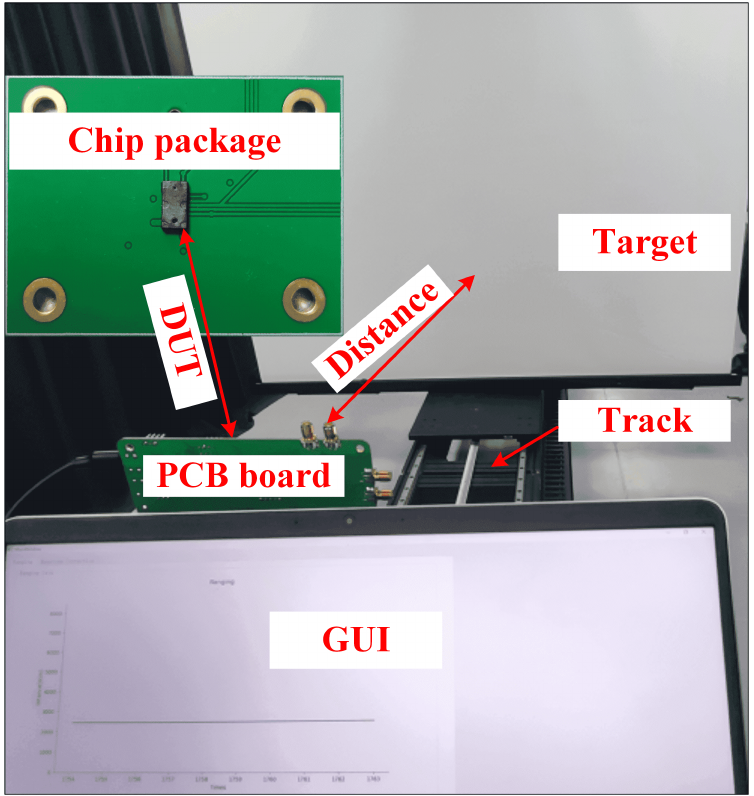
Figure 12. Ranging measurement setup showing how the VCSEL and sensor are